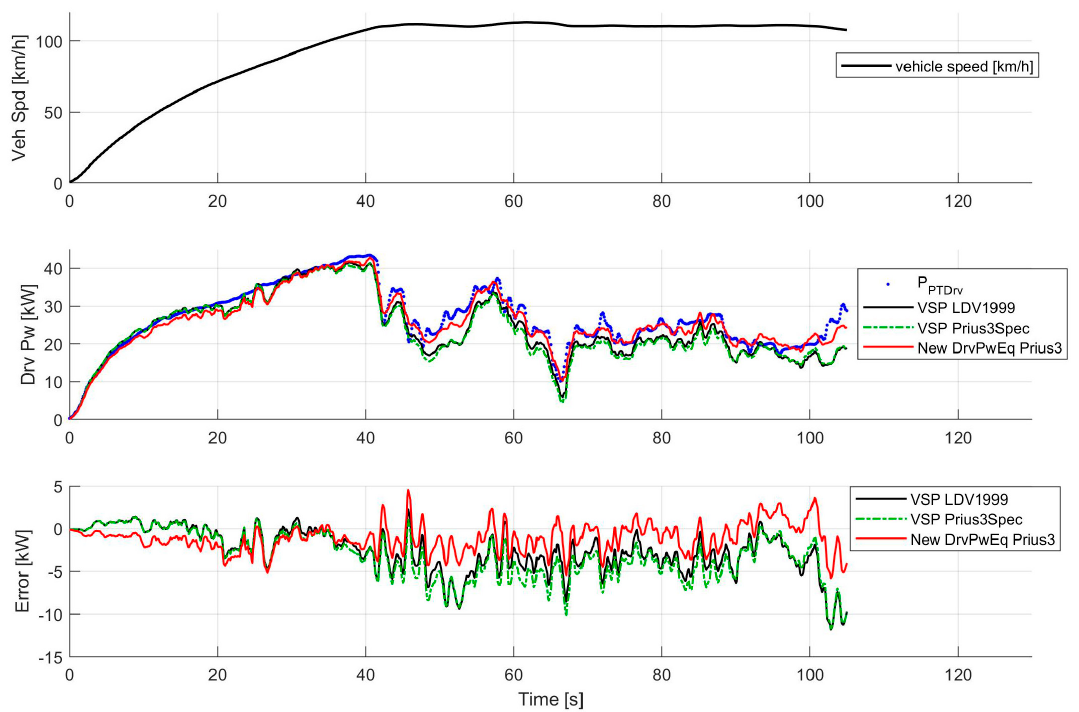
Figure 6. Prius3 driving-power prediction results at light-load driving during naturalistic acceleration and high-speed cruising.